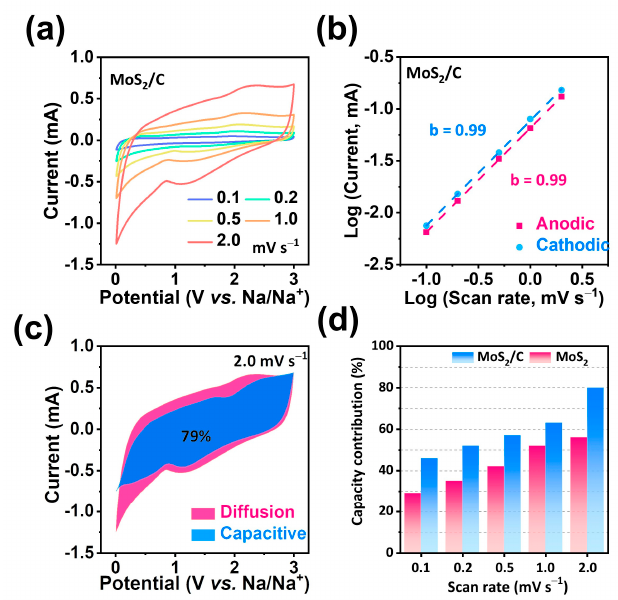
Figure 5. Electrochemical kinetic behaviors. ( a ) CV curves of hollow MoS 2 /C nanoflowers at various current densities. ( b ) Log(i)-log( v ) plots at different cathodic/anodic peaks. ( c ) Normalized contribution ratios of capacitive capacities of MoS 2 /C at a scan rate of 2.0 mV s − 1 . ( d ) Normalized contribution ratios of capacitive capacities MoS 2 /C and MoS 2 at different scan